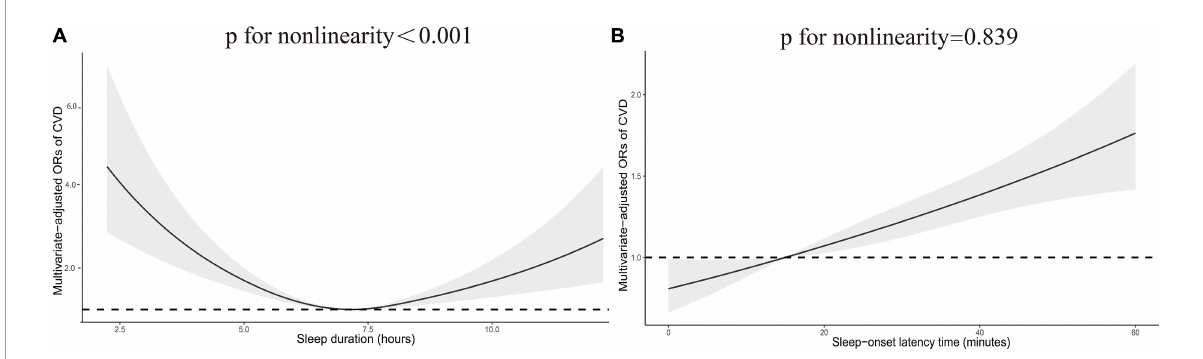
FIGURE2 Restricted cubic spline plot of the association between total CVD and sleep duration (A) and sleep-onset latency time (B) . Adjustments were made according to age, sex, race, education, smoking status, alcohol consumption status, PIR, BMI, diabetes, hypertension, physical activity, TC, HDL-C, and TG. p indicates the results of a test for non-linearity. CVD, cardiovascular disease; OR, odds